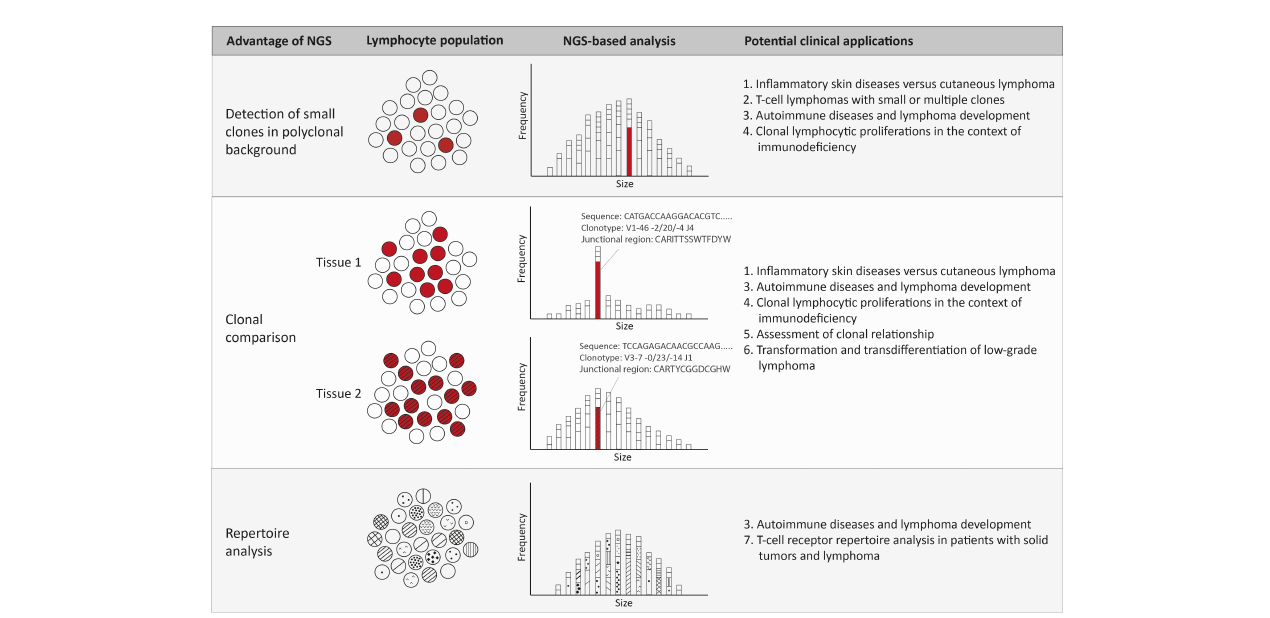
FIGURE 2 Advantages and potential clinical applications of NGS-amplicon based clonality analysis. Using NGS-amplicon based clonality analysis, small clones in a polyclonal background, or even hidden in the polyclonal background, can be more con fi dently detected. A second advantage of NGS is the sequence information and therefore the clonotype information, which is very useful for rapid and reliable clonal comparison. The clonotype obtained from the nucleotide sequence reveals the V, (D) and J gene as well as the junctional region that allows quick and ef fi cient comparison of clonotypes of two or more specimen. Suspected ongoing somatic hypermutation in one of the specimens requires in depth investigation of the nucleotide sequences. The clonotypes also enable detection of the repertoire of the lymphocytes, including early detection of possibly malignant